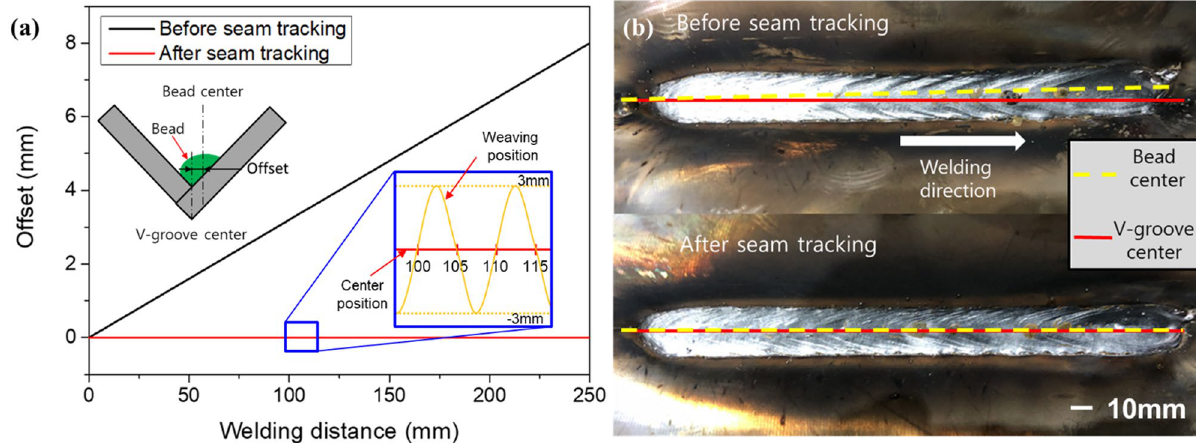
Figure 9. Comparison of results before and after seam tracking. ( a ) Offset between the center of the bead and the center of the V-groove appearing before and after applying the seam tracking. ( b ) Seam tracking